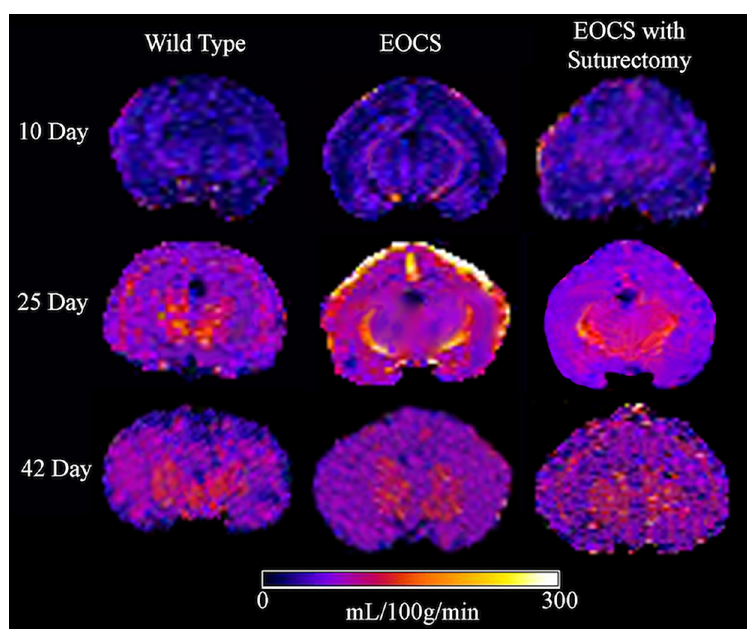
Fig 3. Representative cerebral blood flow maps from wild-type, EOCS, and EOCS with suturectomy rabbits at 10, 25, and 42 days of age. https://doi.org/10.1371/journal.pone.0197296.g003 Table 1. Regional cerebral blood flow by group. Left Right Hemisphere Left Cortex Right Cortex Left Thalamus Right Thalamus Left Superficial Hemisphere